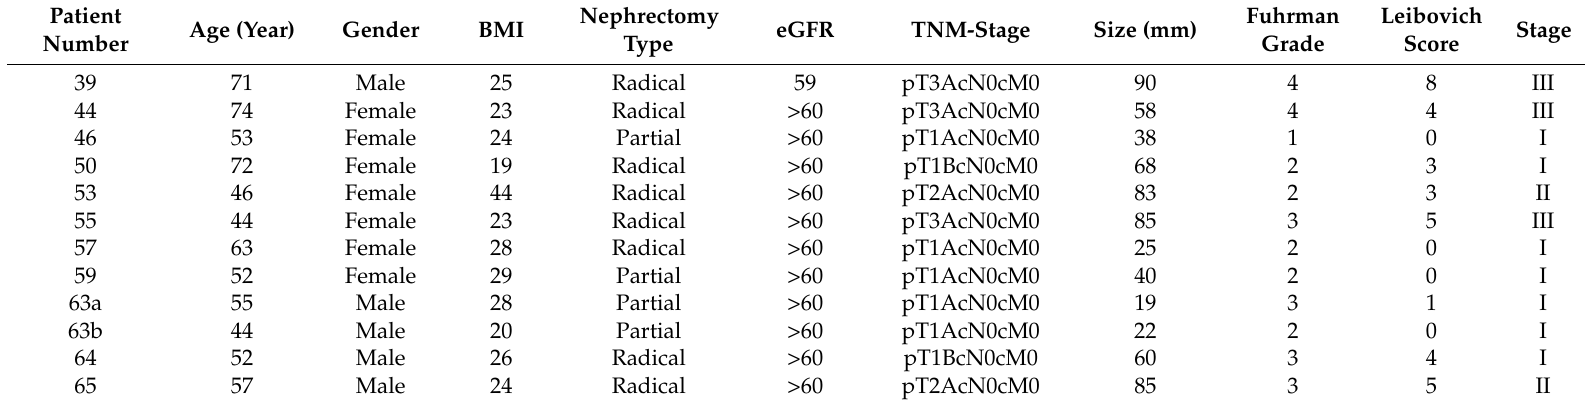
Table 1. Patient characteristics at the time of